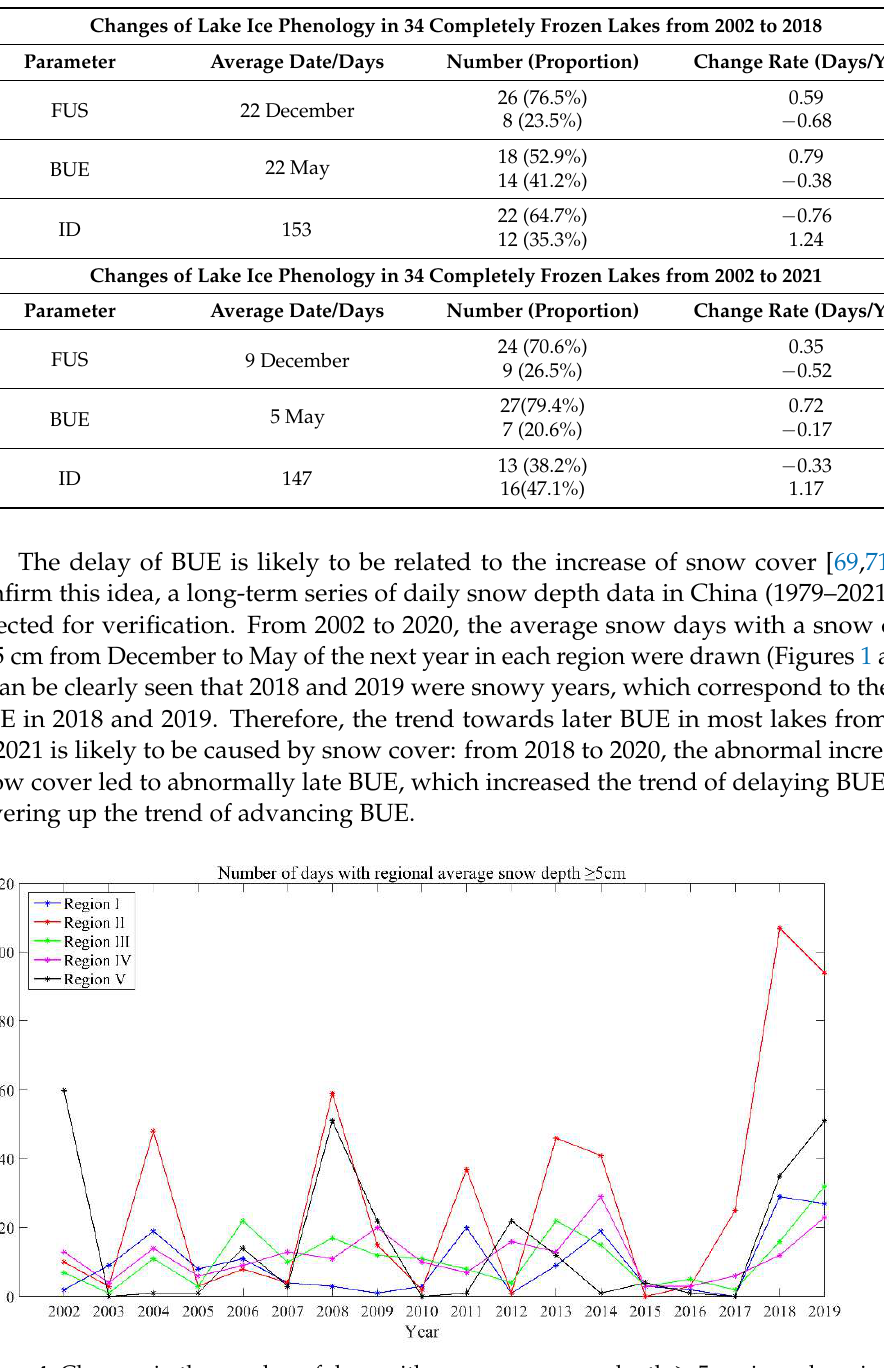
Figure 4. Changes in the number of days with an average snow depth ≥ 5 cm in each region from December to May of the following year. The division of regions is shown in Figure